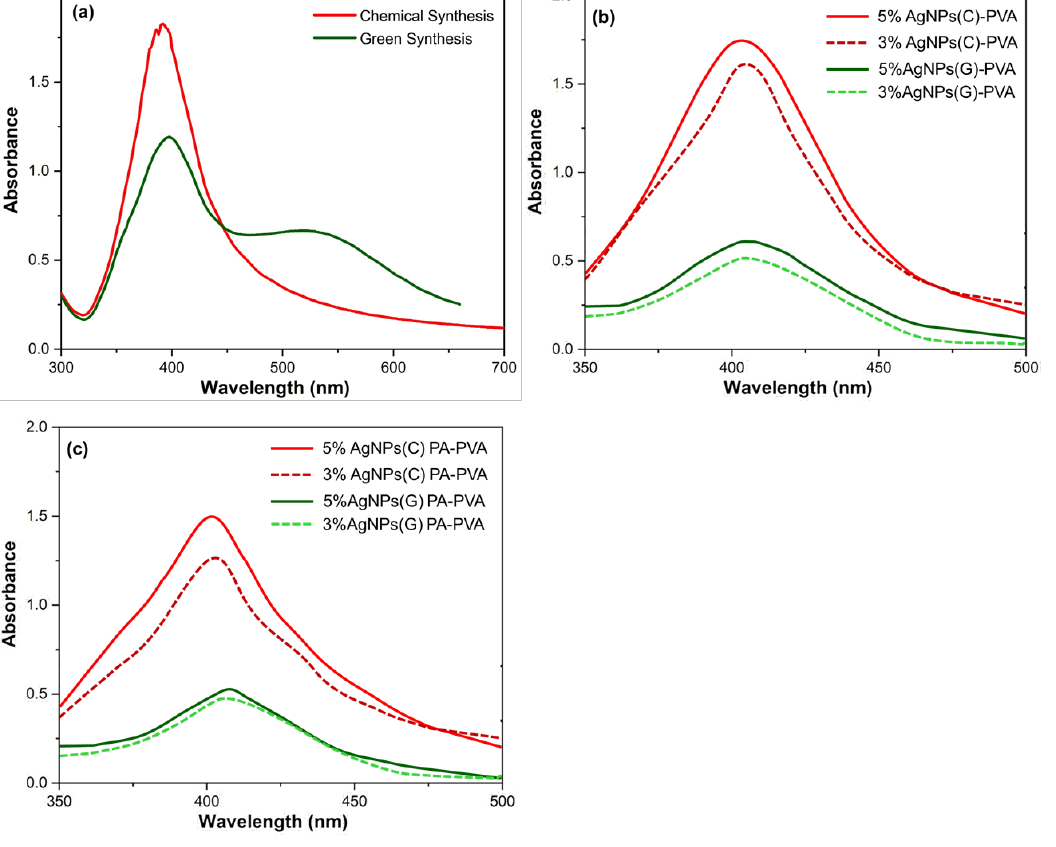
Figure 4. Surface plasmon resonance peaks of: ( a ) Ag–NPs (chemical and green synthesis); ( b ) Ag– NP-encapsulated PVA film; ( c ) Ag–NP-encapsulated